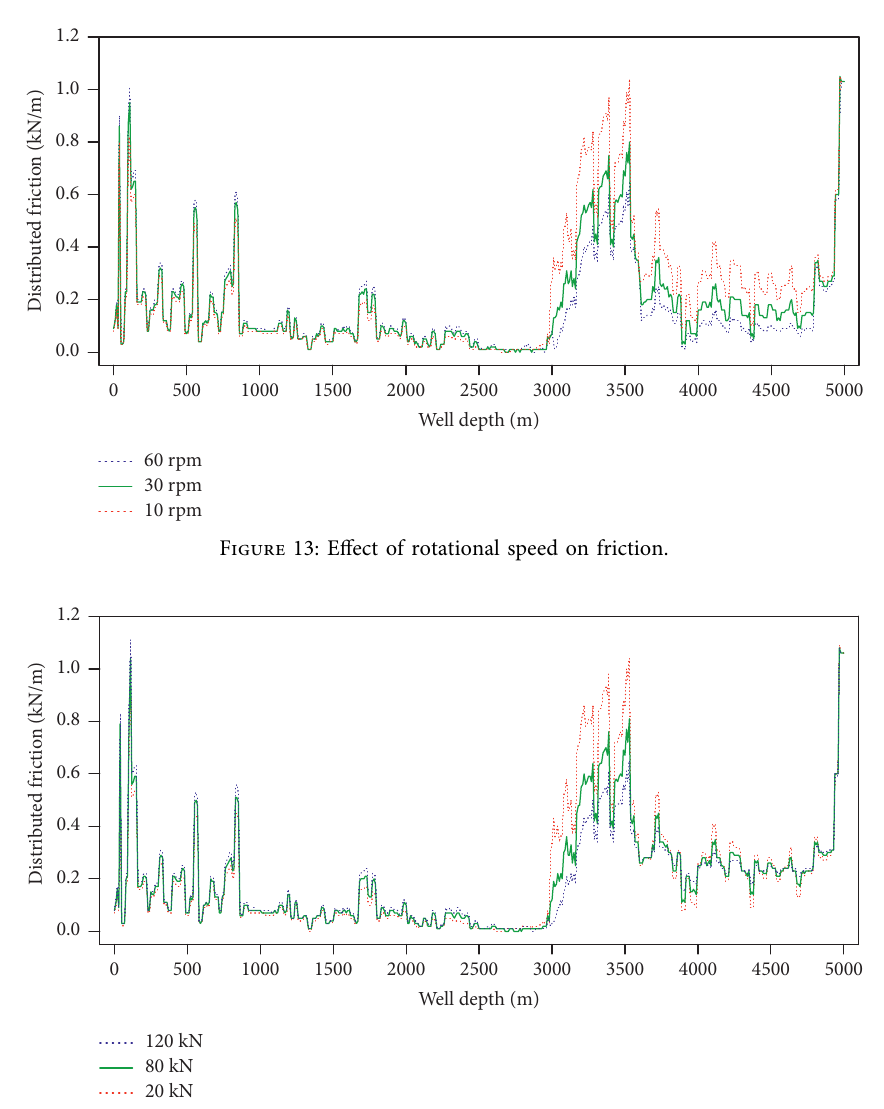
Figure 14: Effect of WOB on